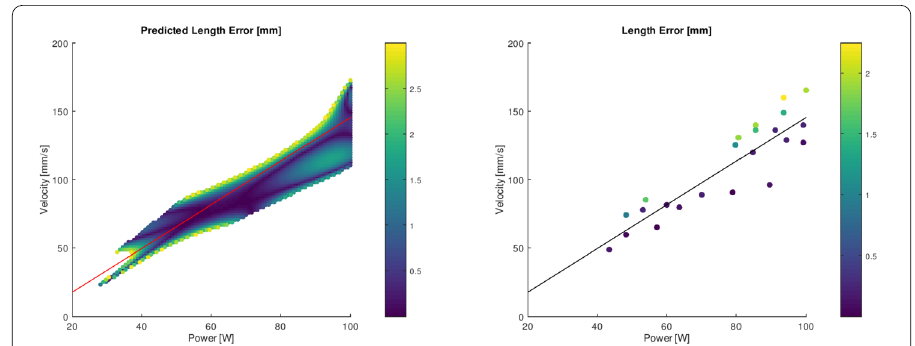
Figure 14 Case Study 2. Left : Predicted Length error [mm] at s = 3.0 mm using last metamodel (iteration k = 3). Right : Length Error of Final Pareto Solutions with s ≥ 2.8 mm. In both cases, the length error is shown as indicated by the color bar and the solid line corresponds to v